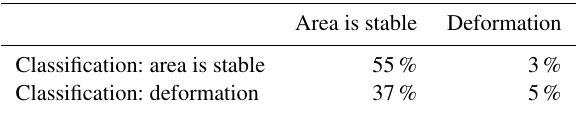
Table 2. Confusion matrix for the classification of the rock glacier. Area is stable